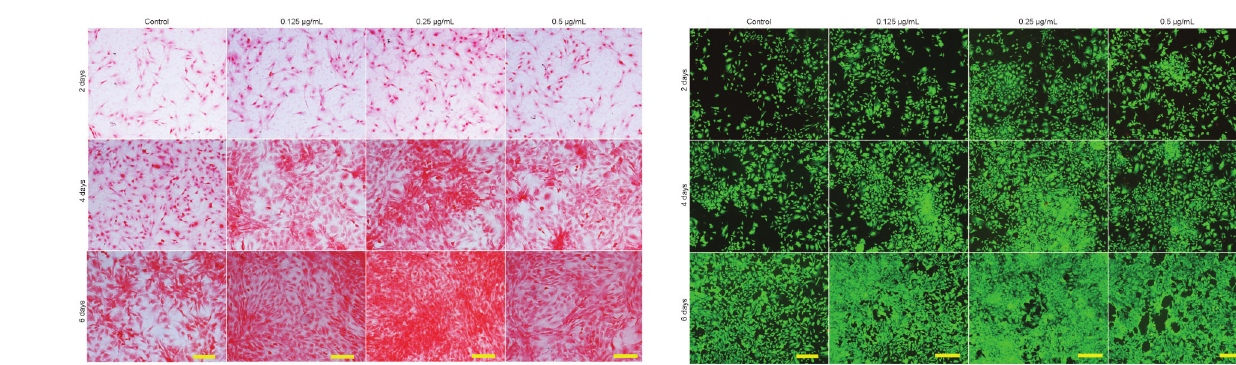
Figure 4. Safranin-O-staining showing the synthesis of extra- cellular matrix by chondrocytes cultured in vitro with 0 (control), 0.125, 0.25, and 0.5 m g/mL JJYMD-C for 2, 4, and 6 days. Scale bar: 100 m m.